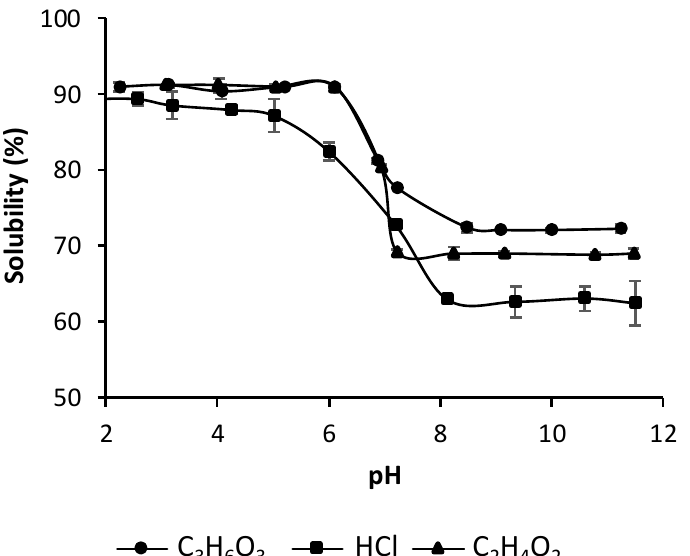
Figure 7. Solubility of Chitosan-CGNA with different acids at pH range from 2 to 11. Results are presented as means ± standard deviations (n = 3).